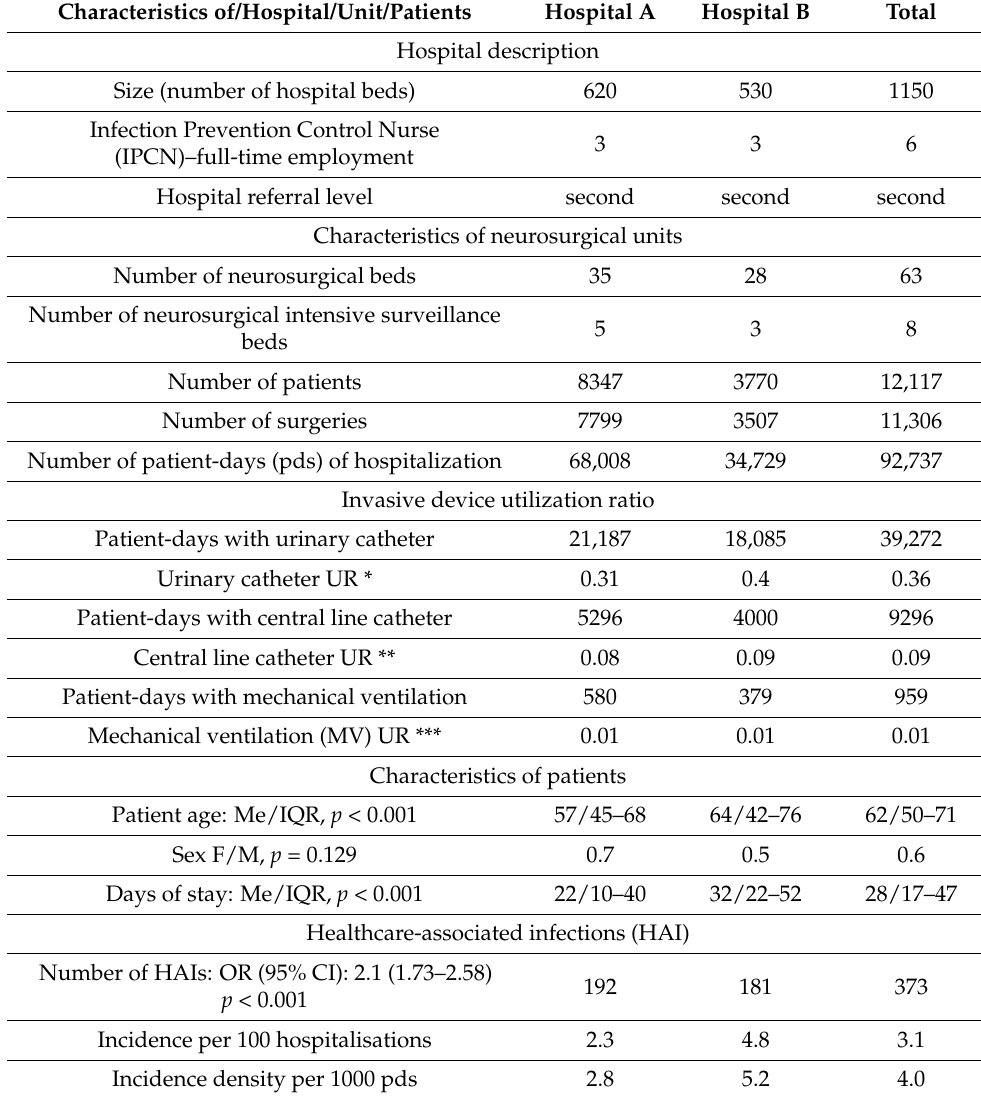
Table 1. Characteristics of the hospitals studied: neurosurgery departments, patients, use of invasive devices, incidence per 100 hospitalizations and 1000 person-days from 2014 to